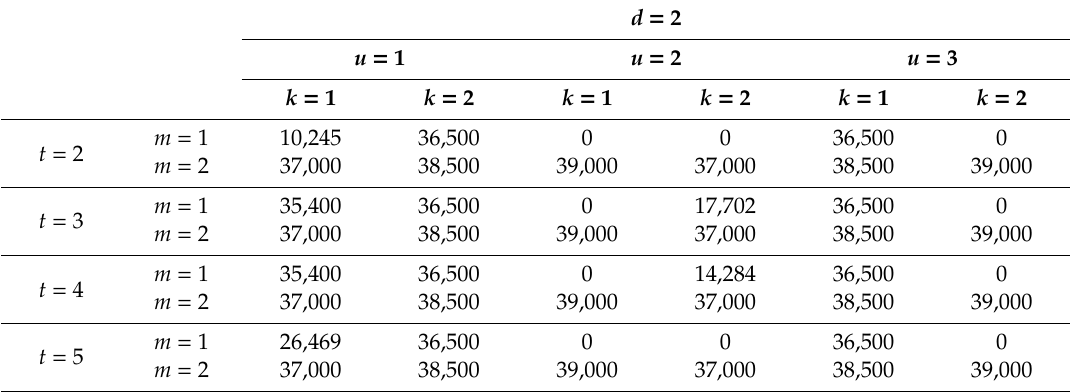
Table A1. Quantity of surgical instruments supplied by manufacturers to distributor “ d = 2” in periods t =